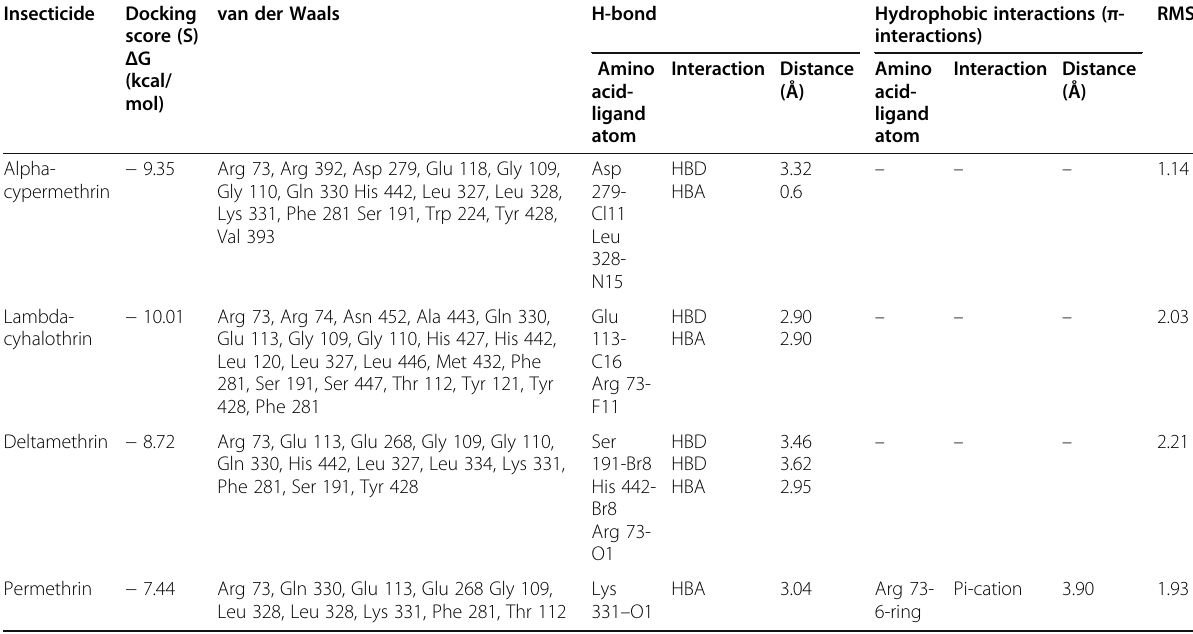
Table 5 Molecular docking, binding scores and binding interactions of tested pyrethroids within the active sites of CaE (PDB ID: 5W1U)